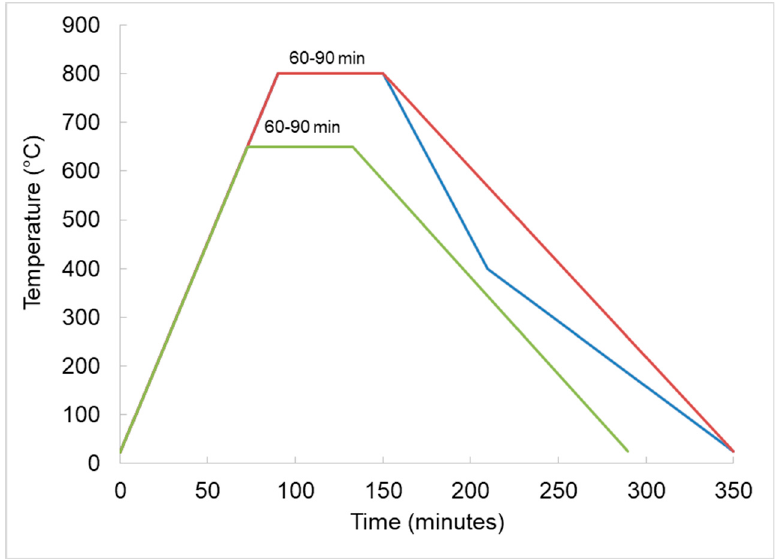
Figure 7. Sintering heating schedule for Cu ‐ xFe 3 O 4.